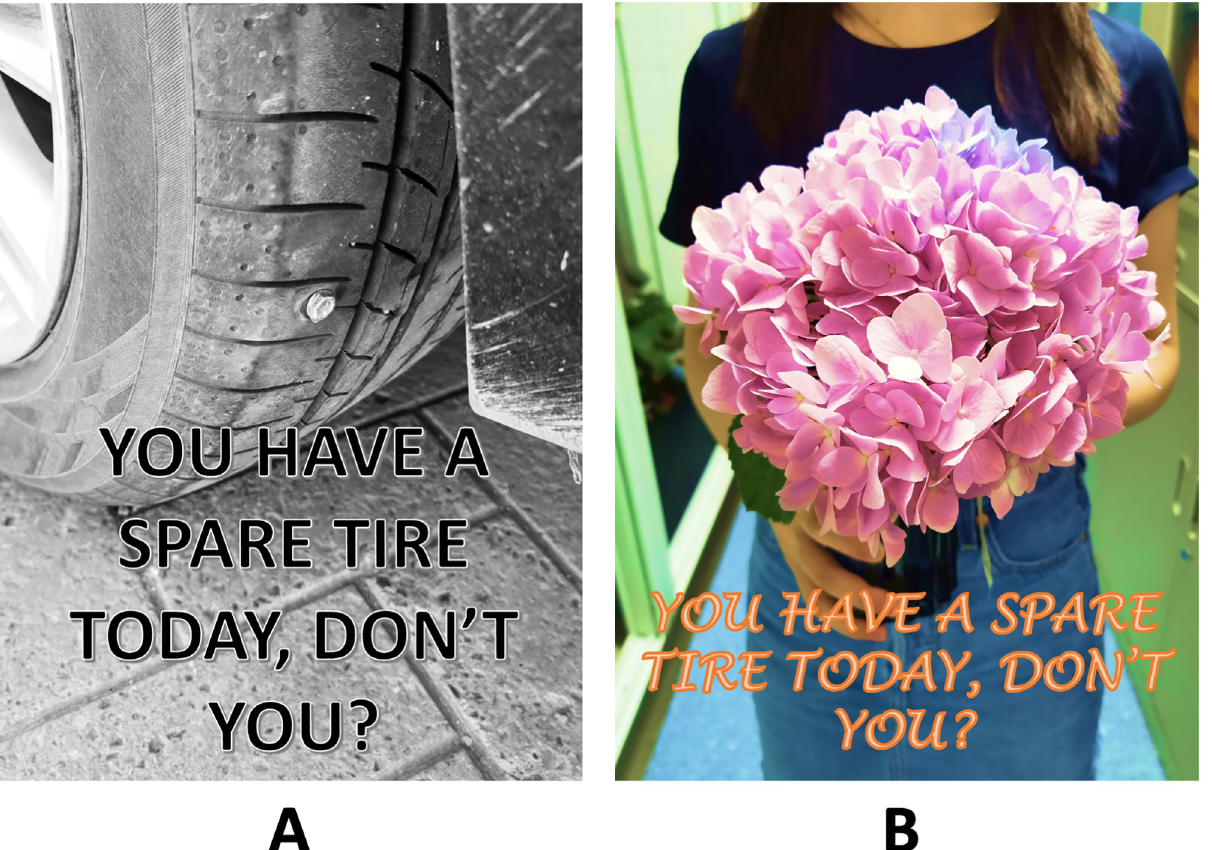
Fig 1. Examples of hateful and non-hateful memes. In meme A (non-hateful), the image of a nailed tire and the sentence “You have a spare tire today, don’t you?” are both neutral, as well as the combined version; in meme B (hateful), the same caption is inscribed as meme A, but the image part is changed from a nailed tire to the "girl holding flowers", has a reversed implication from neutrality to insulting as hateful. Besides, in meme B (hateful), neither the image part nor the caption expresses hatred alone, yet when combined, this meme expresses hatred. (Copyrighted by author F. Pan).